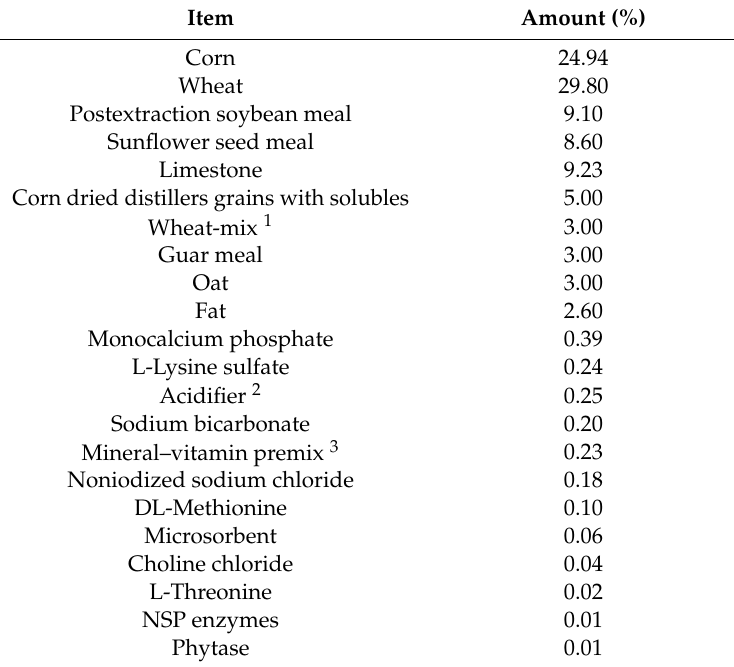
Table 3. Ingredients and the chemical composition of the basal